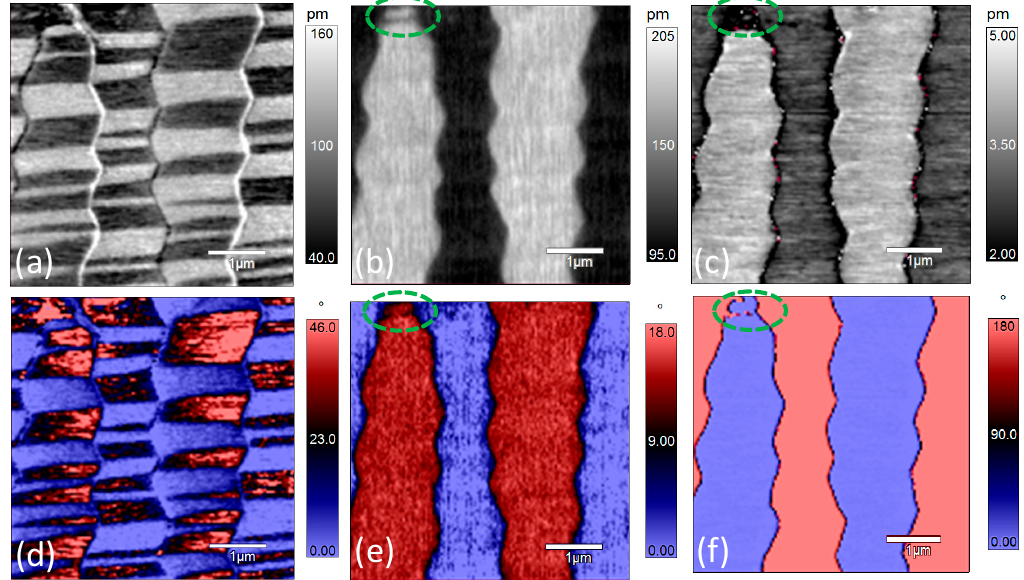
Figure 5. PFM amplitude and phase images of (001)-cut PZN-7%PT single crystal at 75 °C: ( a – c ) amplitude images of x-LPFM, y-LPFM, and VPFM, respectively; and ( d – f ) phase images of x-LPFM, y-LPFM, and VPFM, respectively.